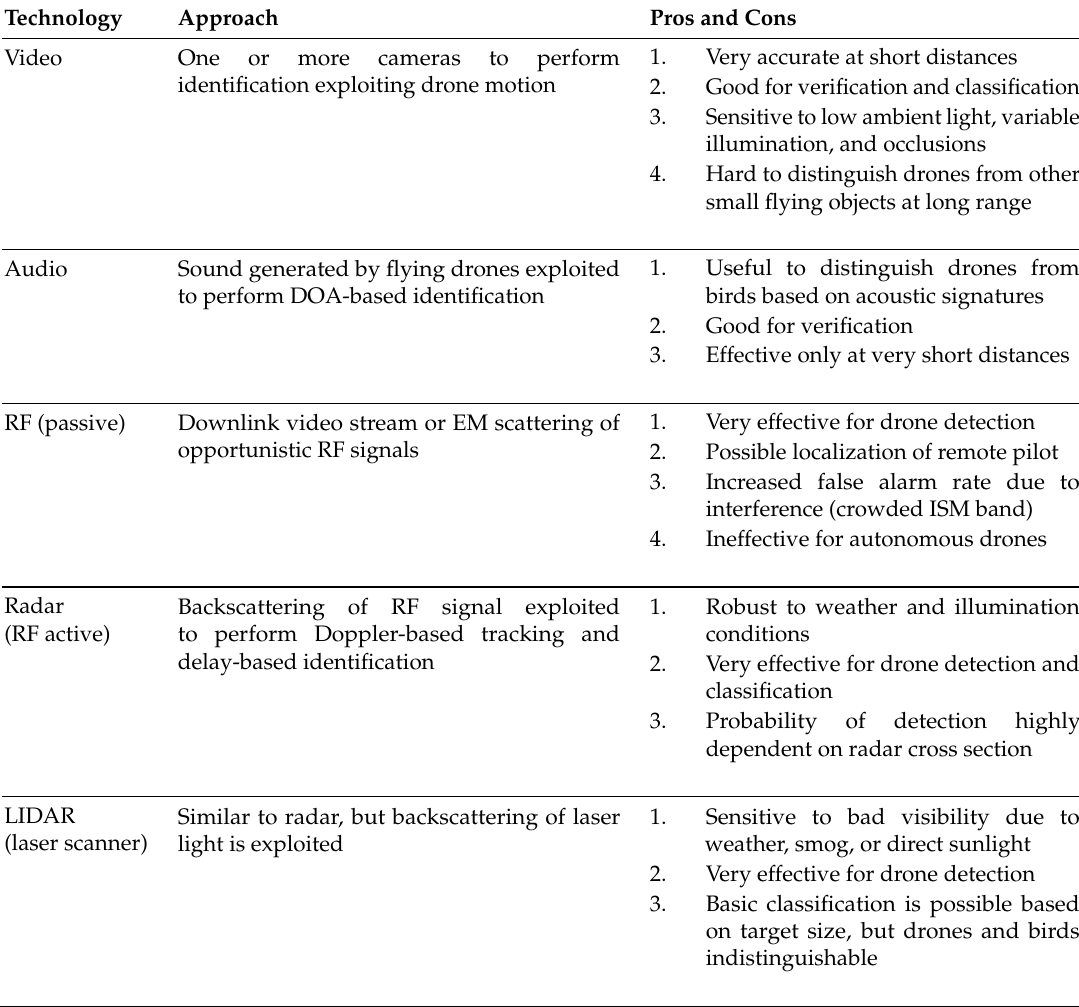
Table 1. Comparison among drone surveillance